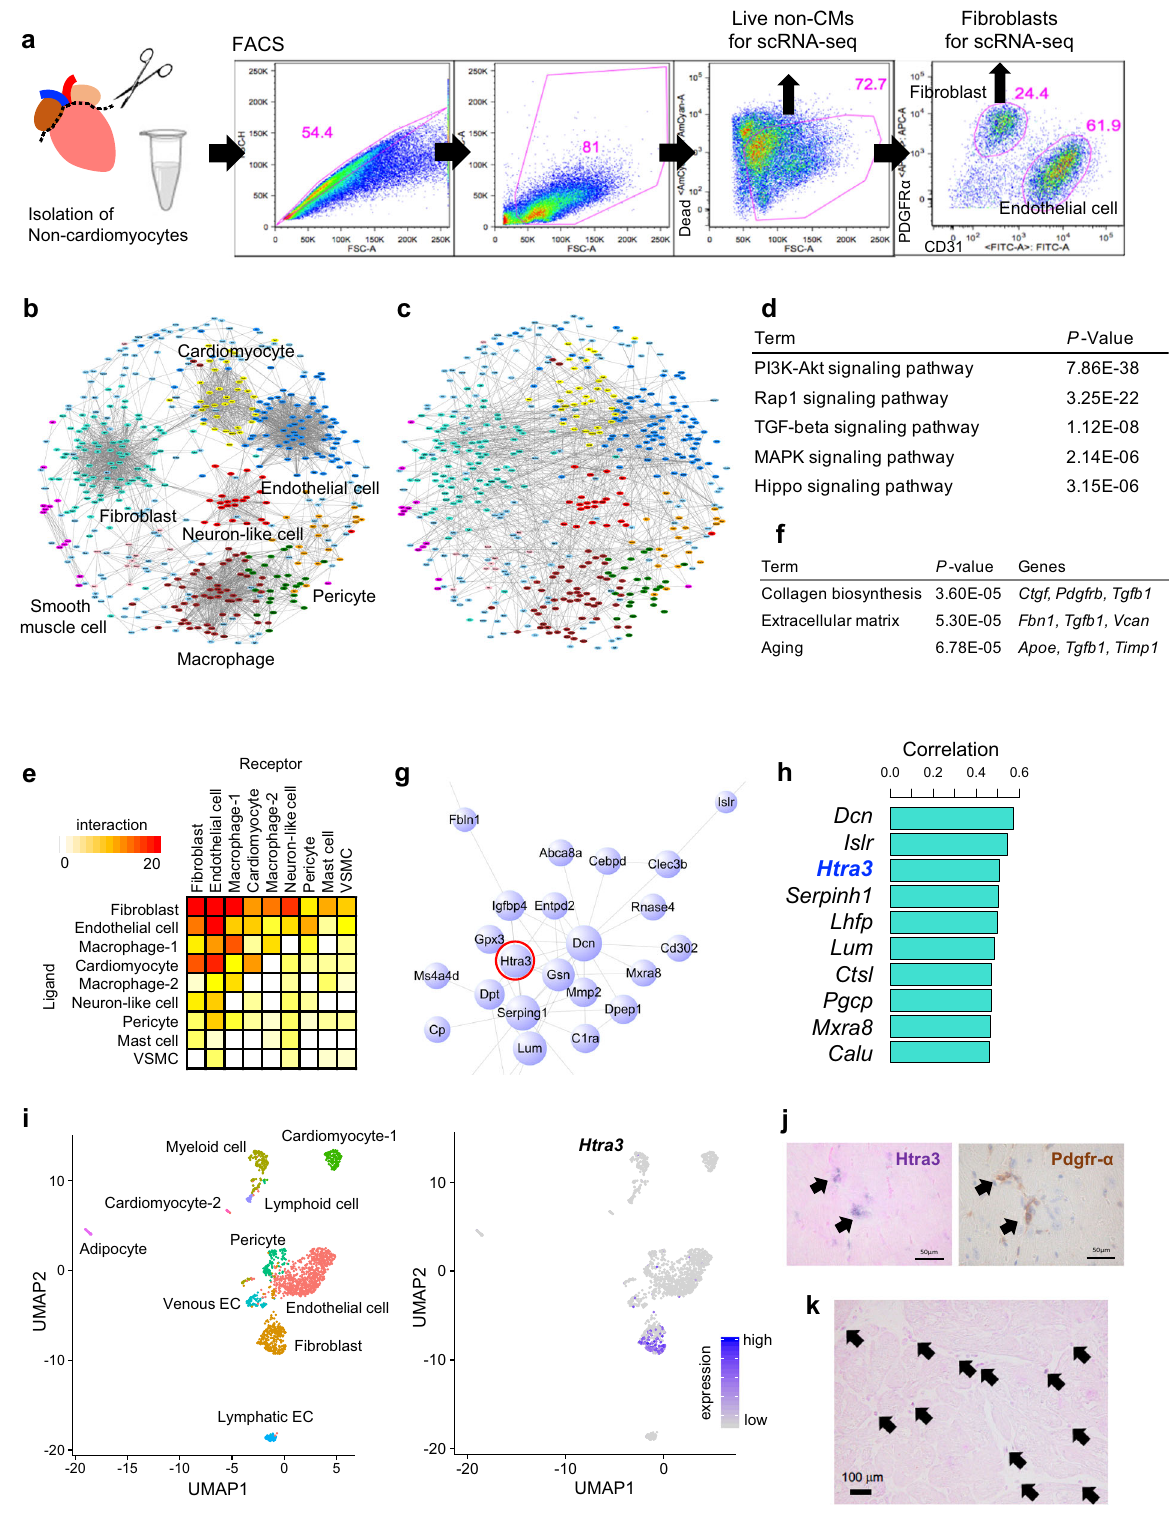
β signaling molecules, such as Tgfb3 and Tgfbr2 , and Postn , a marker of activated cardiac fi broblasts 6 , was activated only in trajectory 2 (Fig. 3i). These fi ndings indicate that Htra3 basically inhibits TGF- β signaling and that pressure overload and Htra3 deletion synergistically activates TGF- β signaling, leading to activation of fi